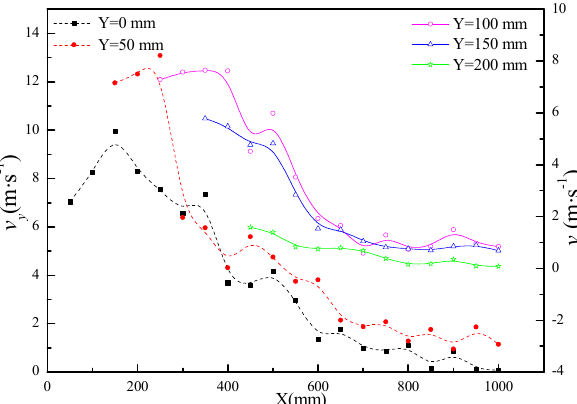
Figure 9. Comparison curve of the radial velocity along the axial direction.